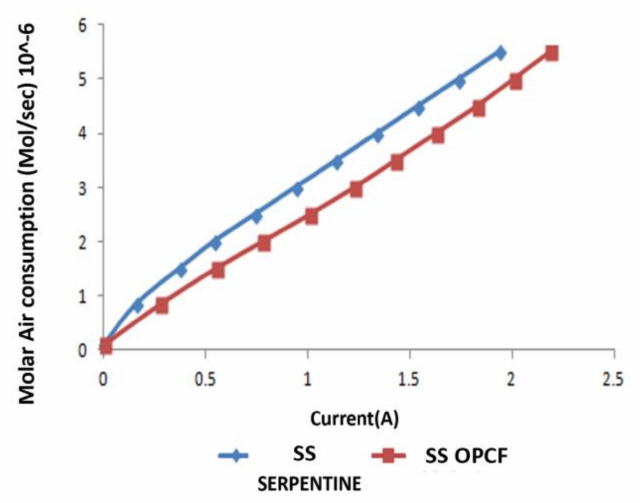
Figure 13. Air consumption (SS bipolar plate material).